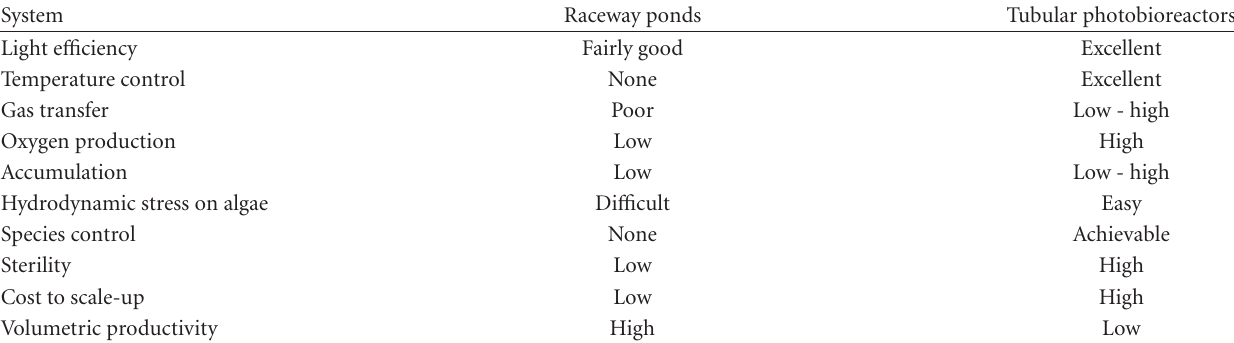
Table 2: Comparison between microalgal cultivation systems